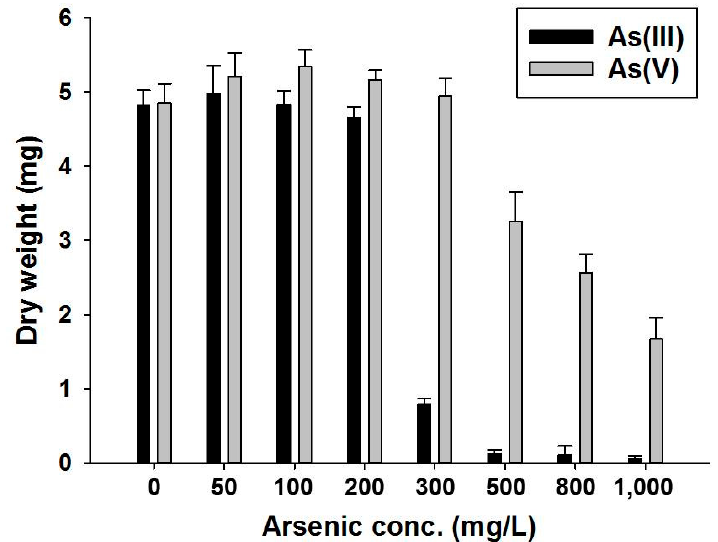
Figure 1. Changes in biomass of Talaromyces sp. KM-31 after 15 days of cultivation on PDA medium augmented with arsenic. The As(III) and As(V) concentrations ranged from 0 to 1000 mg / L. Table 1. Arsenic tolerance index for Talaromyces sp. KM-31 at varying concentrations of As(III) or As(V) in PDB and PDA media after 15 days of cultivation, and arsenic removal rates in PDB